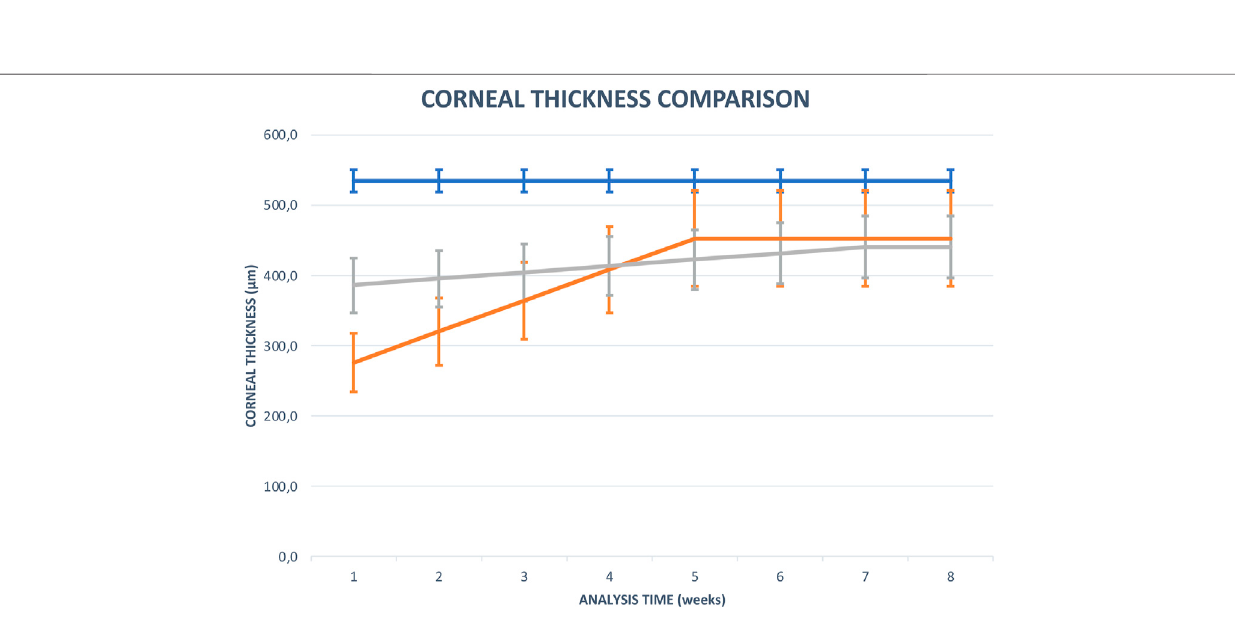
Frontiers in Pharmacology |